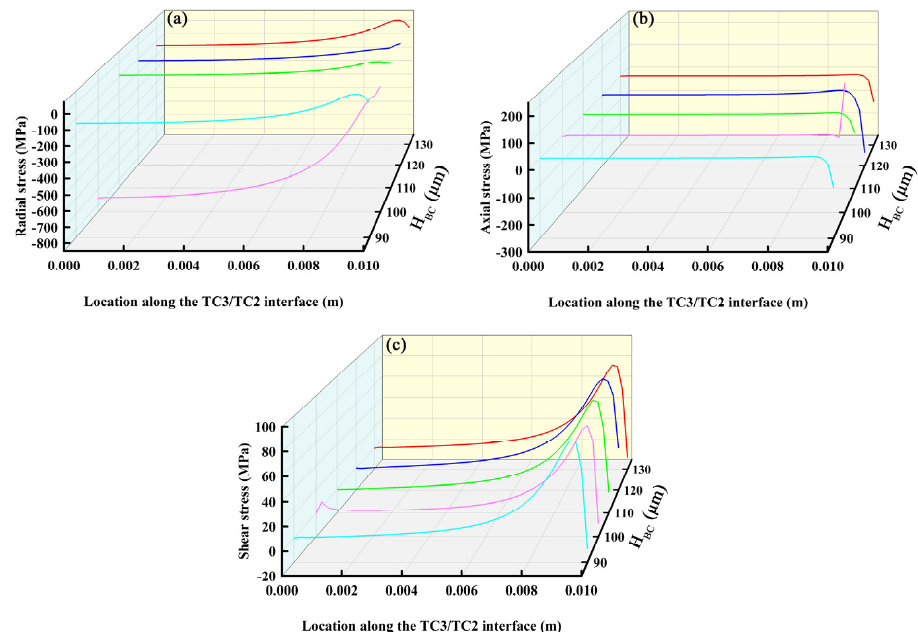
Figure 8. Stress distributions along TC3/TC2 interface: ( a ) radial stress; ( b ) axial stress and ( c ) shear stress.